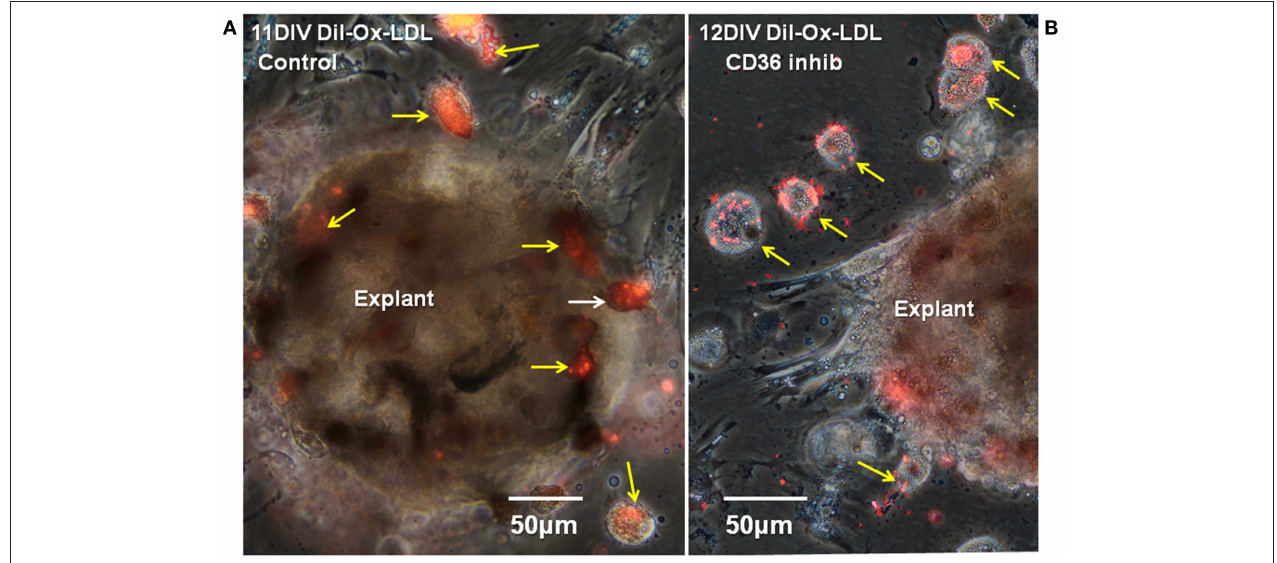
FIGURE 8 | CD36 inhibition reduces DiI-Ox-LDL uptake by foamy macrophages. Seventeen days regenerate spinal cord regenerate explants, were treated with DiI-Ox-LDL at 10DIV for 24h as the control (A) or with the CD36 inhibitor sulfo-N-succinimidyl oleate added at 10DIV plus DiI-Ox-LDL added at 11DIV for 24h. (B) Inhibitor-treated explants showed less uptake of DiI-Ox-LDL in comparison to control. D, day; DIV, days in vitro ; Ox-LDL, oxidized low-density receptor; inhib, inhibitor; Regen, regeneration. Magnification bar is shown in the lower portion of each